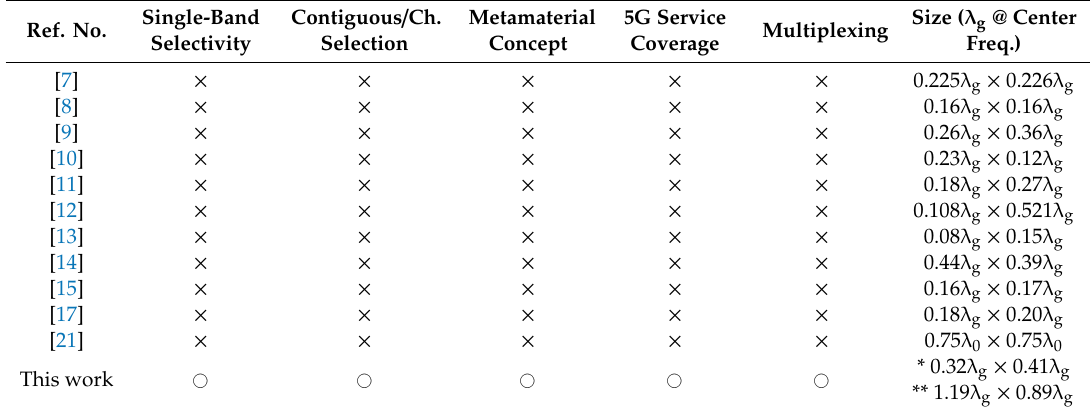
Table 2. Comparing the di ff erences of the proposed work and others’. Ref.